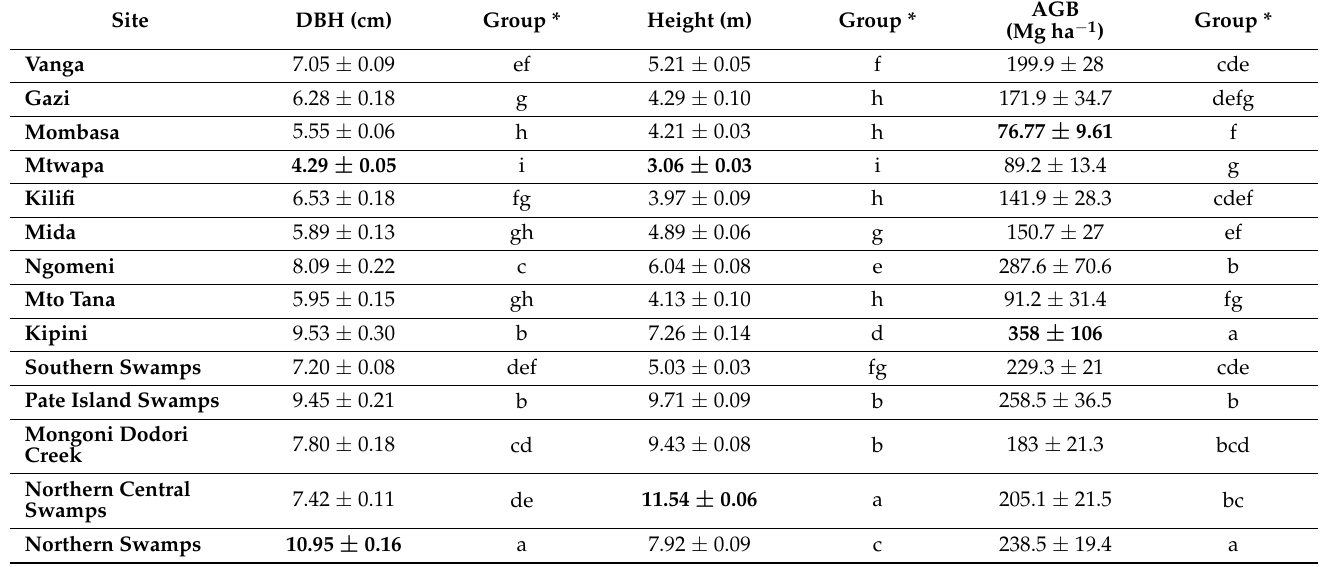
Table 3. Structural attributes of mangroves in the 14 sampling sites along the Kenyan coast. Values are reported as mean ± standard error. The grouping information * from the post-hoc Tukey pairwise comparison post-hoc test at 95% confidence level is reported alongside each variable—the means that do not share a letter are significantly